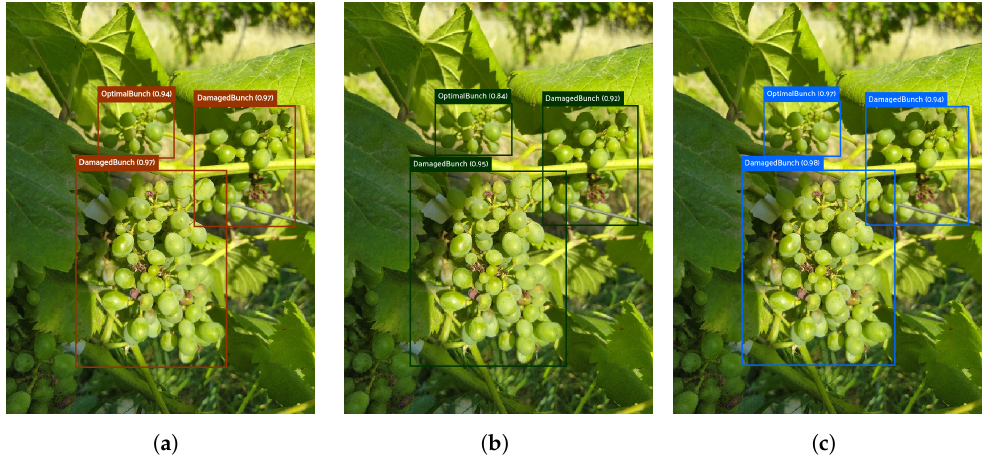
Figure 8. Detection of the condition of grape bunches in samples from the test set. Red bounding boxes present the predictions from YOLOv5. Green bounding boxes present the predictions from YOLOv7. Blue bounding boxes present the predictions from YOLOR. ( a ) YOLOv5. ( b ) YOLOv7. ( c )